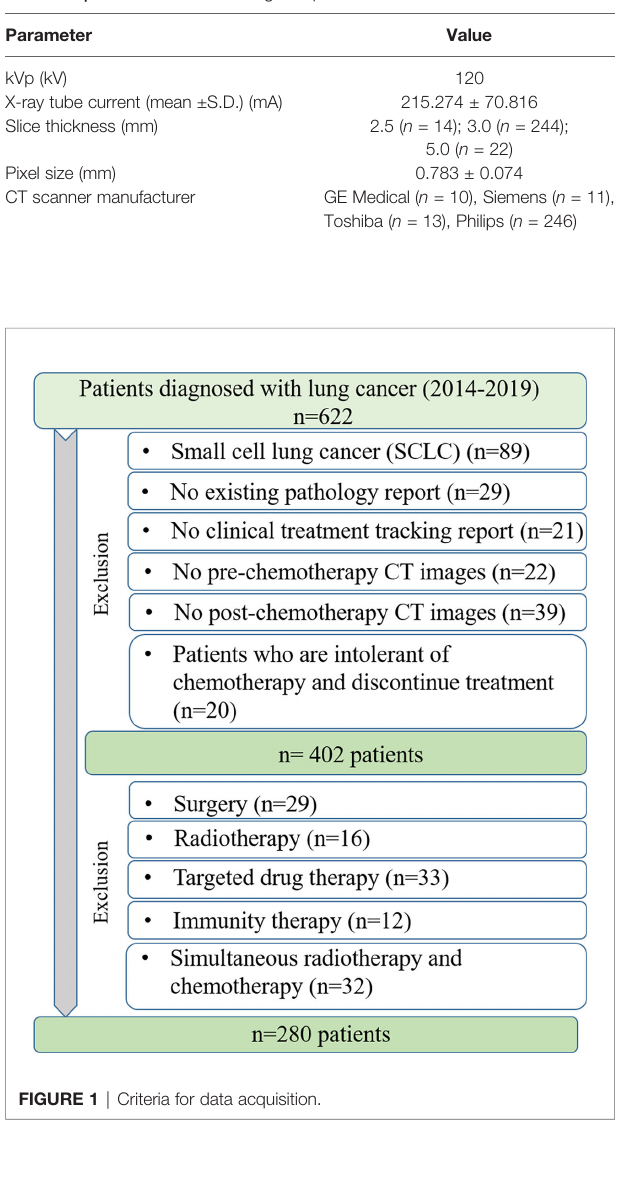
TABLE 1 | Parameters for CT image